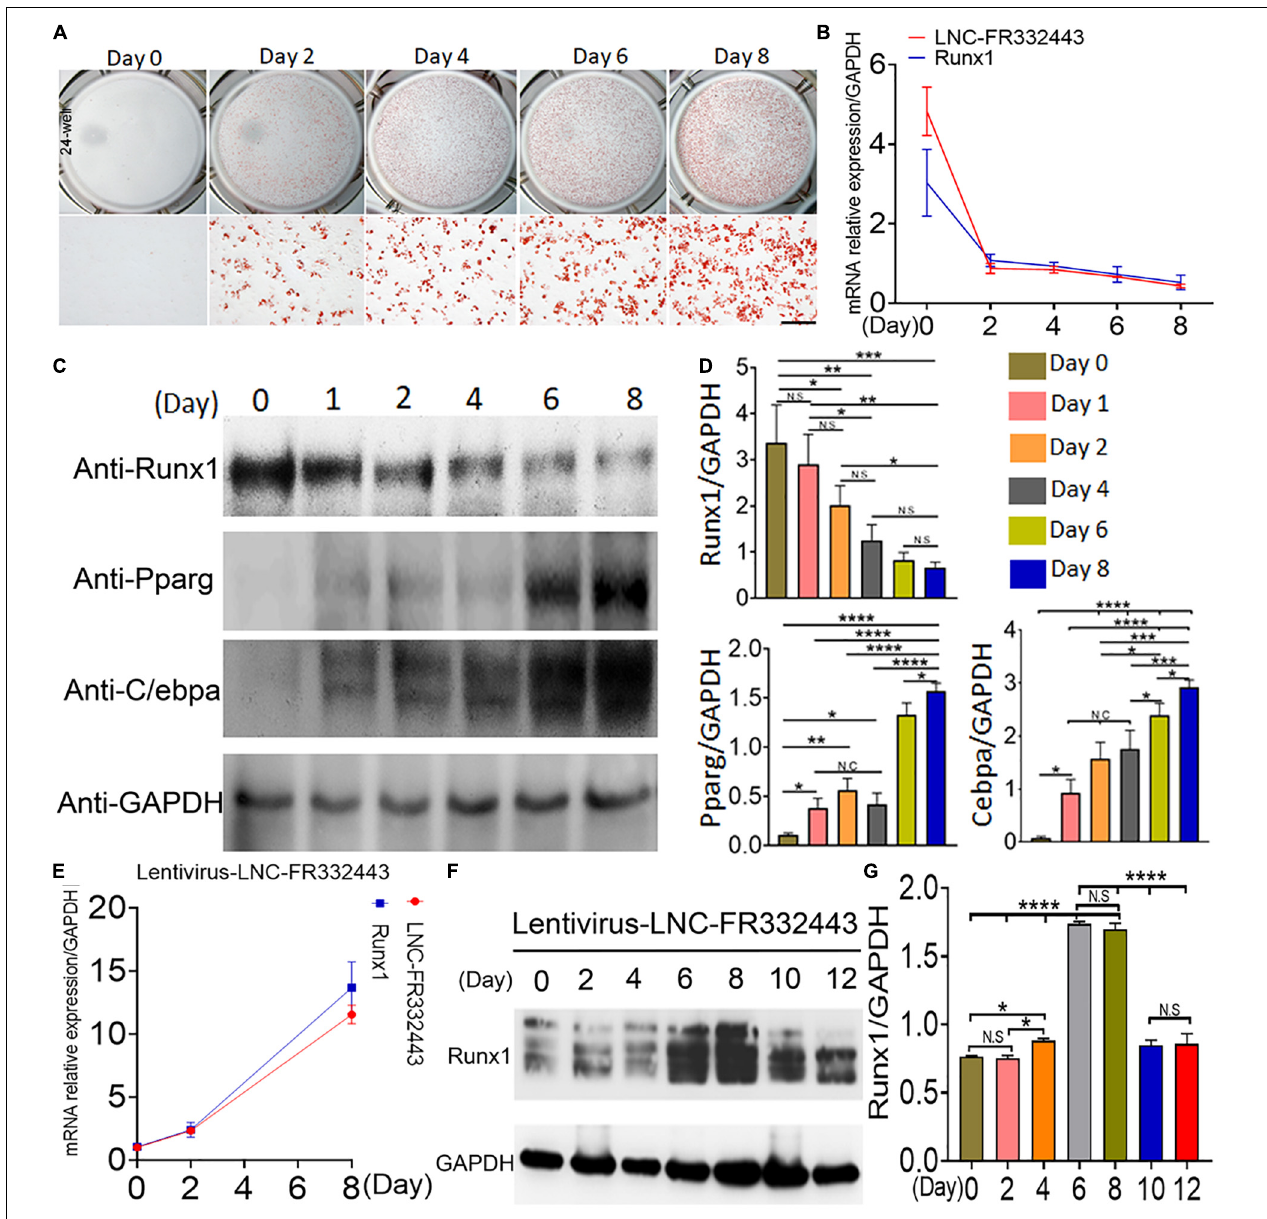
FIGURE 4 | Downregulation of Lnc-FR332443 and Runx1 expression during adipogenic differentiation. (A) Oil red O staining of mouse 3T3-L1 preadipocyte adipogenic differentiation at days 0, 2, 4, 6, and 8. Scale bar, 200 µ m. (B) The Lnc-FR332443 and Runx1 mRNA levels during 3T3-L1 preadipocyte differentiation on different days. (C) Western blot analysis of Runx1 and adipogenic marker (anti-PPAR γ and anti-C/EBP α ) protein levels in 3T3-L1 preadipocytes differentiated on different days. (D) The quantification data of panel (C) . (E) The time course of Lnc-FR332443 and Runx1 mRNA expression during 3T3-L1 preadipocyte differentiation after infection with lentivirus-Lnc-FR332443. (F) Western blots of Runx1 protein expression in the 3T3-L1 preadipocytes differentiated on different days after lentivirus-Lnc-FR332443 infection. (G) The quantification data of panel (F) . All the data are shown as the mean ± SEM, NS denotes not significant, N = 3, * P < 0.05, ** P < 0.01, *** P < 0.001, and **** P <